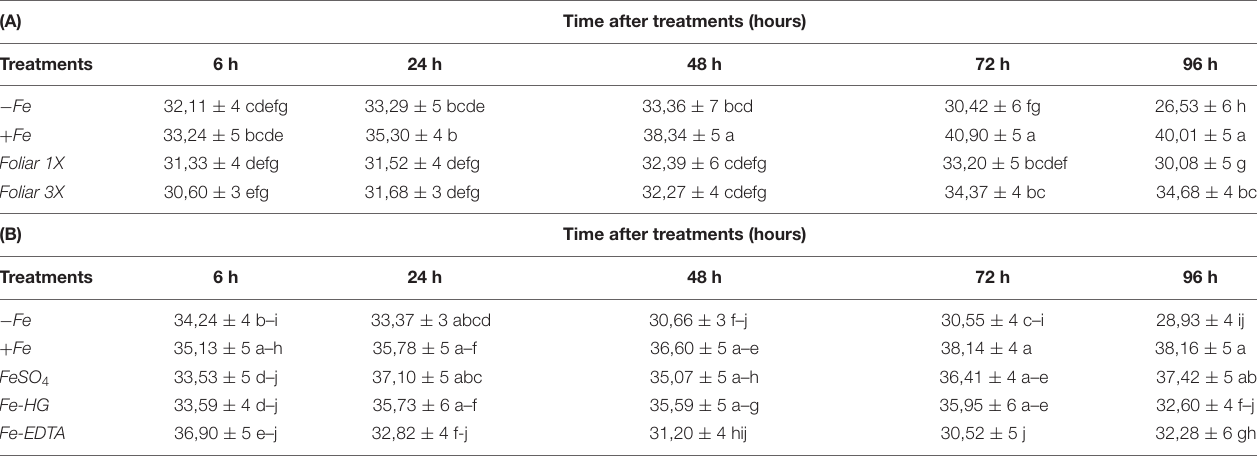
TABLE 2 | SPAD values measured in cucumber leaves from: (A) Experiment I and (B) Experiment II. (A) Time after treatments (hours)